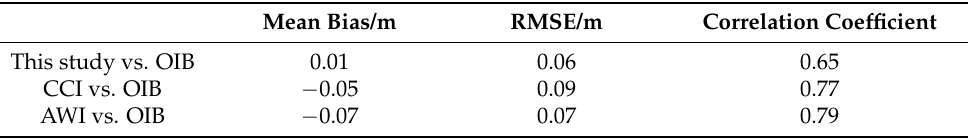
Table 7. Statistics of the comparison of the sea ice freeboard across this study, the two products, and OIB. Mean Bias/m RMSE/m Correlation Coefficient This study vs. OIB 0.01